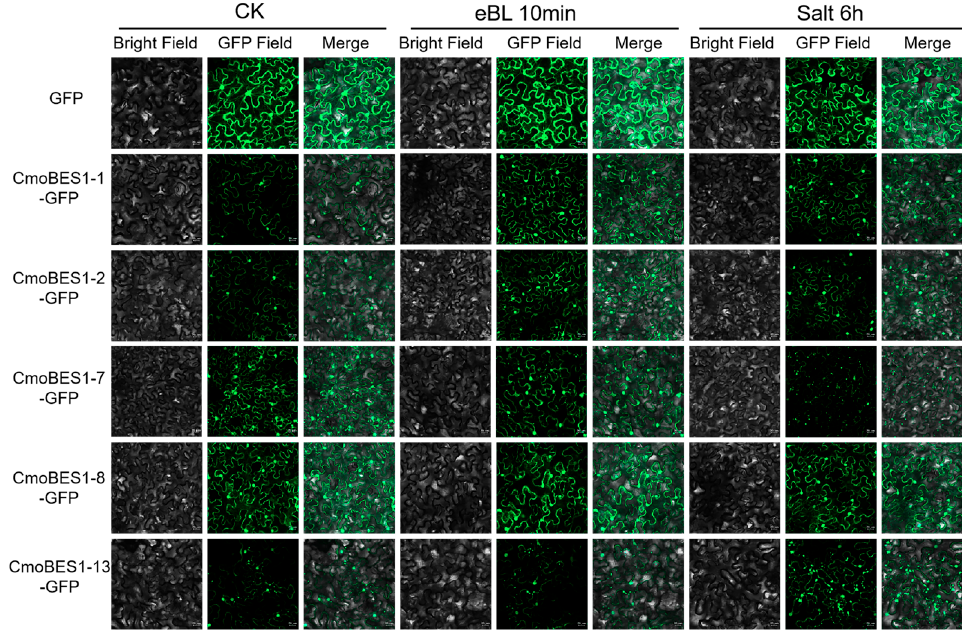
Figure 7. Subcellular localization of CmoBES1 proteins under eBL and salt treatments in Nicotiana benthamiana leaves. Each line contains the bright field, GFP field, and merged photos of CmoBES1-1, -2, -7, -8-GFP, and GFP control. The length of the scale bar is 20 µ